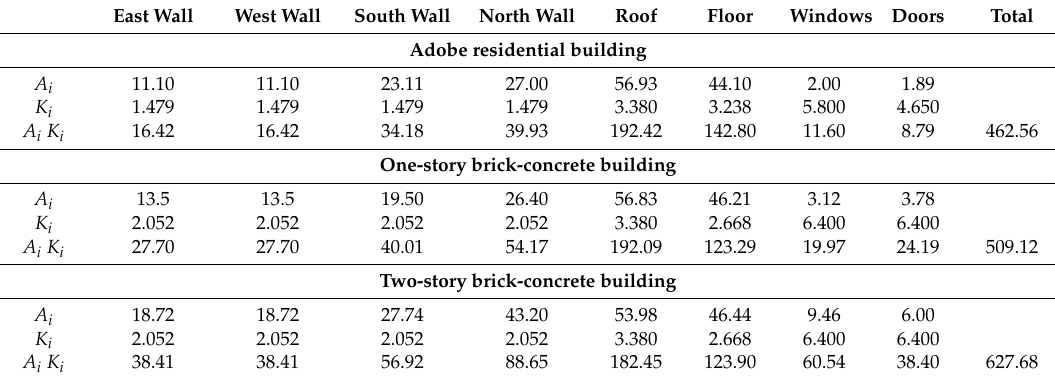
Table 13. The calculated A i K i value for closure structure in three residential buildings.